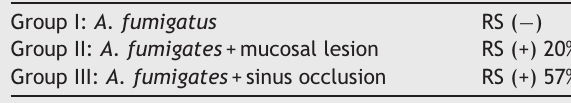
Incidence of rhinosinusitis in the groups of the study by Drettner et al. (1987).